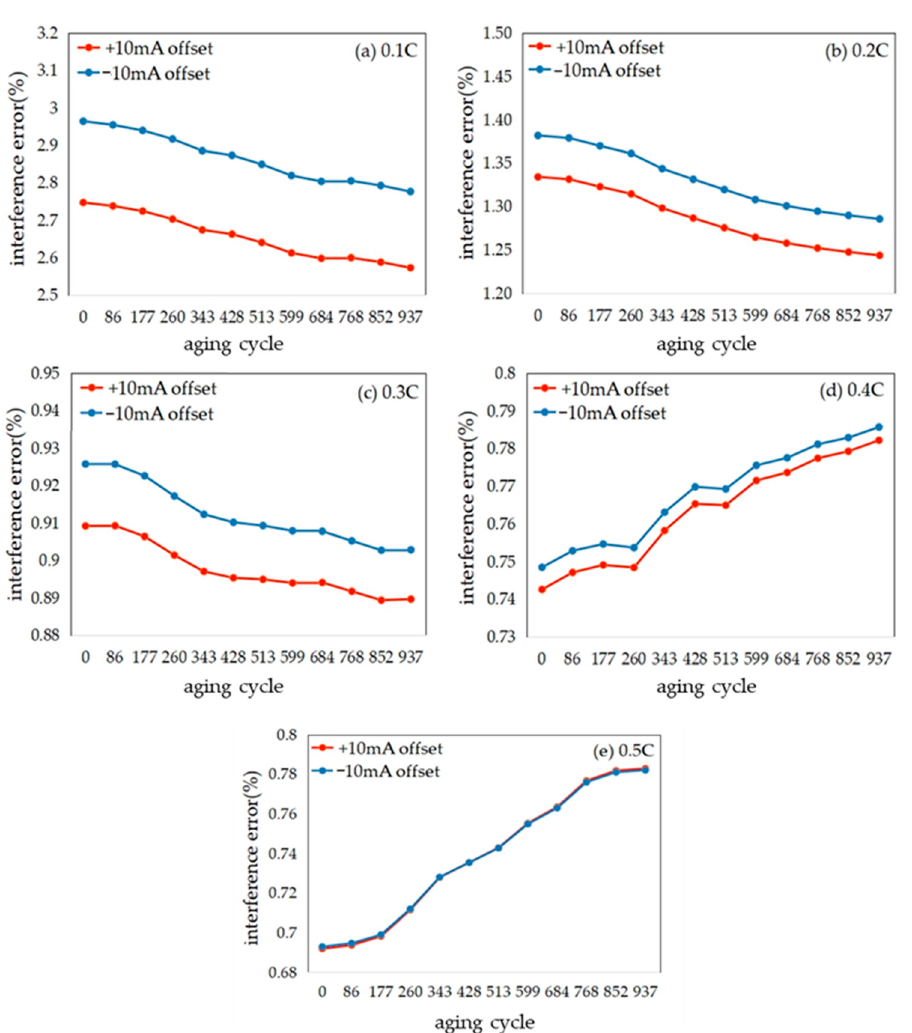
Figure 8. Interference error generated by ± 10 mA offset of the fitting method.